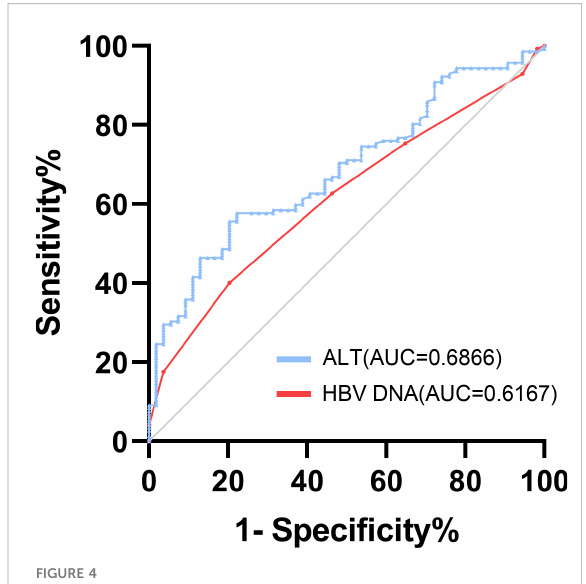
FIGURE 4 ROC curve analysis used to calculate the best cut-off point of ALT and HBV DNA level for predicting the occurrence of re- compensation of ascites in patients with HBV-related fi rst decompensated cirrhosis of ascites. Best cut-off points of ALT and HBV DNA levels as 46.1 IU/L (sensitivity%,57.70% and speci fi city%, 77.80%) and 5 log 10 IU/mL (sensitivity%,33.35% and speci fi city%, 81.95%). The area under curve (AUC) of ALT and HBV DNA were 0.6866 [95% con fi dence interval (95%CI):0.609- 0.764, P<0.001] and 0.6167 [95% con fi dence interval (95% CI):0.534-0.699, P=0.012], respectively. AUC, area under the curve; ROC, receiver operating